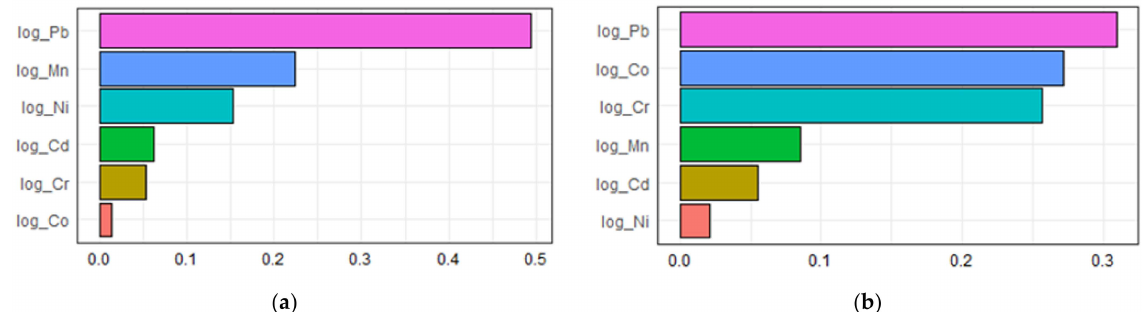
Figure 3. The associations between urinary metal levels and serum adiponectin levels based on weighted quantile sum regression analysis ( a ) unadjusted; ( b )